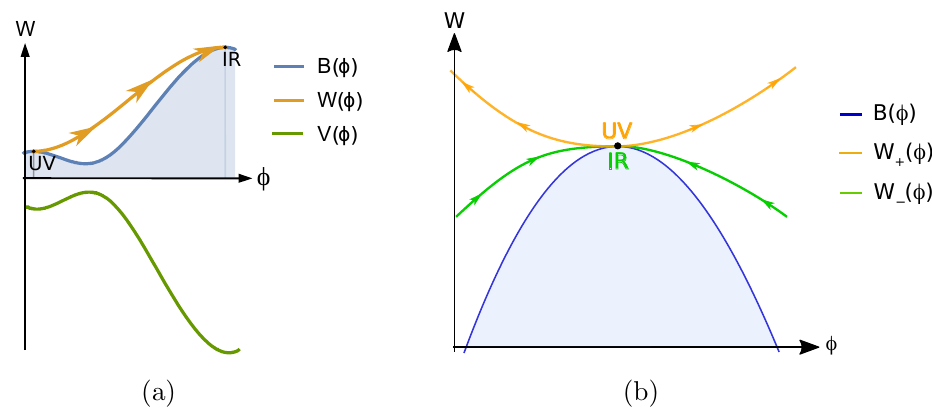
Figure 28 . A minimum to minimum (cid:13)ow is displayed. The left (cid:12)gure (a) shows a schematic picture of the superpotential (yellow curve) and the bulk potential (green curve). The curve B ( (cid:30) ) is de(cid:12)ned via equation (A.18) and is the boundary of the forbidden region below which the zero-temperature superpotential cannot go. The right (cid:12)gure (b) shows a sketch of solutions of the superpotential equation with critical point at a local minimum of the potential (local maximum of B ( (cid:30) )). The W + ( (cid:30) ) and W (cid:0) ( (cid:30) ) solutions correspond each to two asymptotically AdS geometries in the UV and IR, respectively. The corresponding geometries are not connected, as each (cid:13)ow stops (or starts) at the (cid:12)xed point. The arrows on W (cid:0) ( (cid:30) ) and W + ( (cid:30) ) indicate the direction of the holographic RG